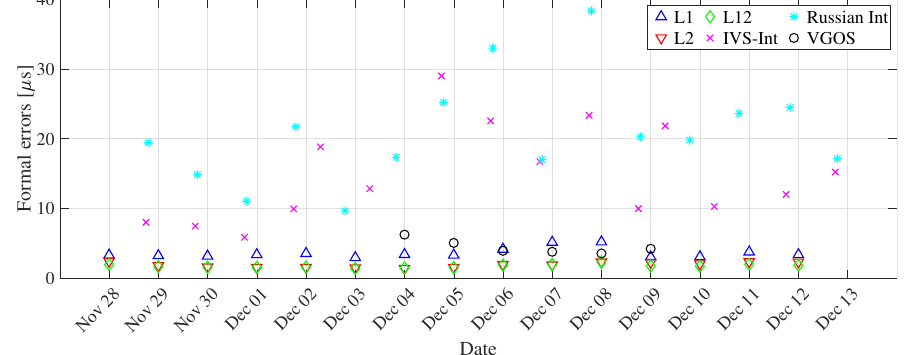
Figure 4. dUT1 formal errors derived from L1, L2, and L12 networks, IVS and Russian Intensives, and VGOS networks for daily resolution (using global solutions).